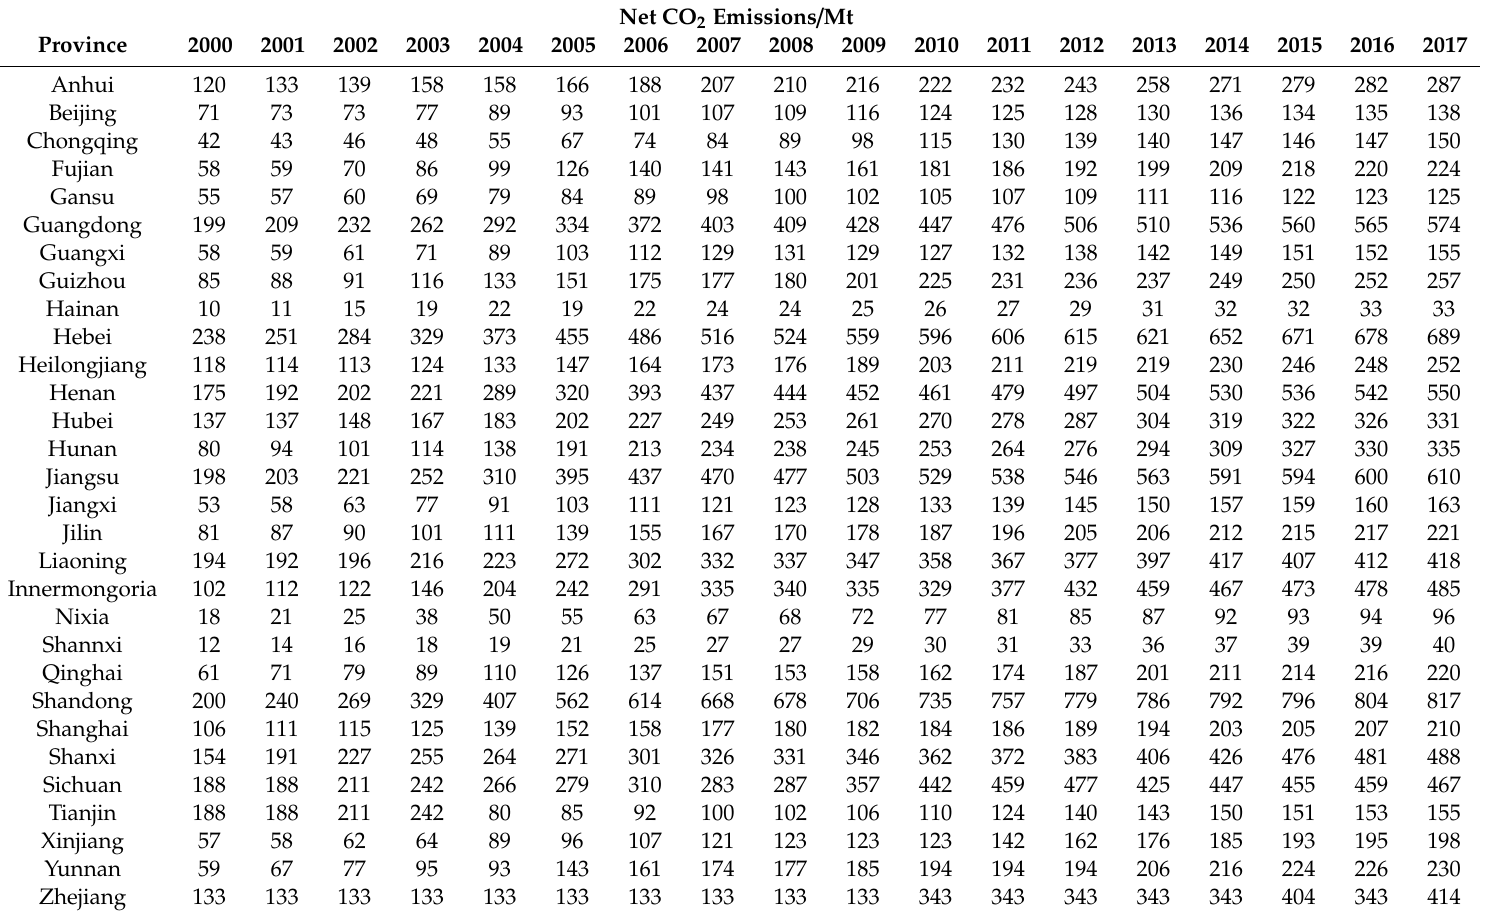
Table A1. The net CO 2 emissions in Chinese Provinces